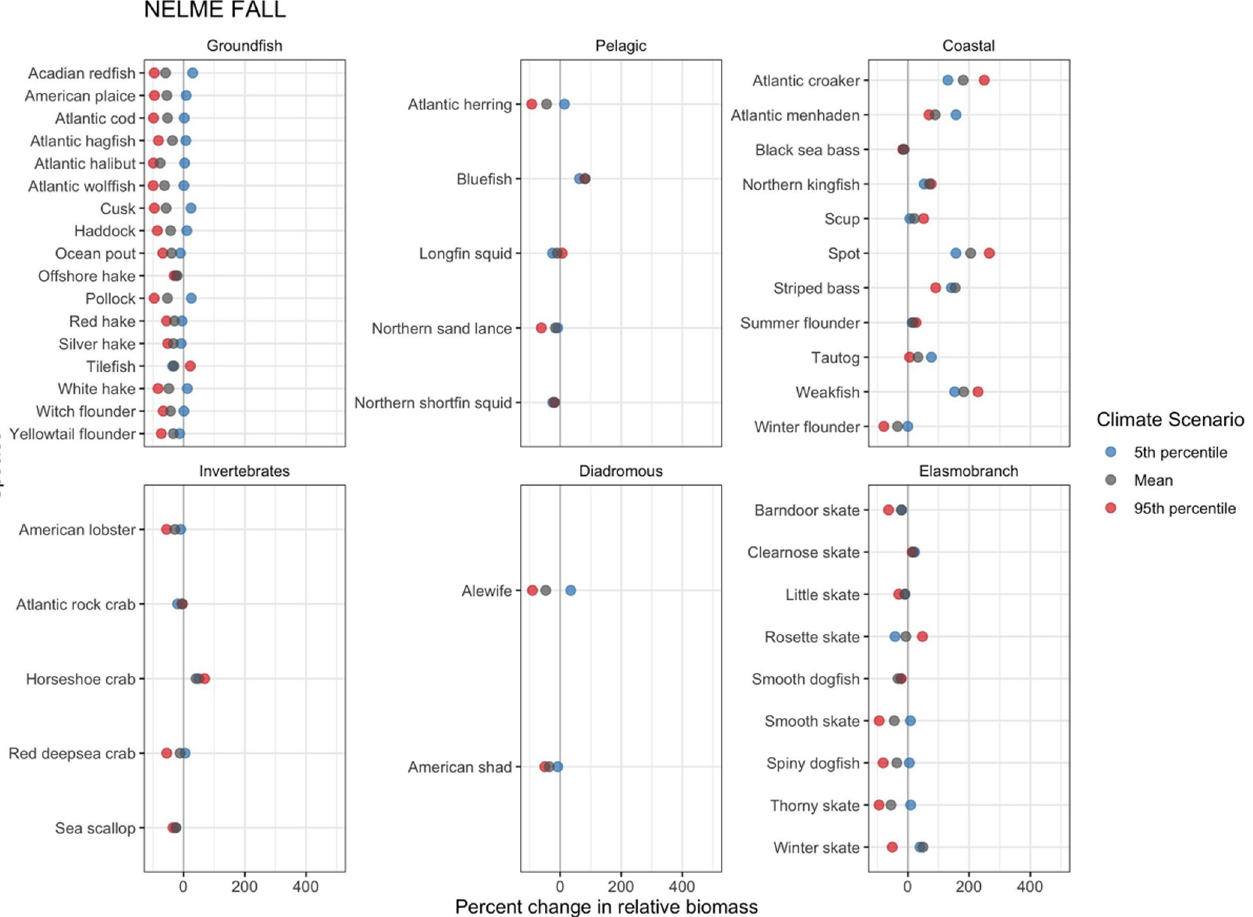
Fig 5. Fall projected shelf-wide percent change in relative species biomass. Projected species relative biomass changes given the 5th percentile, mean, and 95th percentile CMIP5 RCP 8.5 climate model ensemble projected sea surface temperatures.